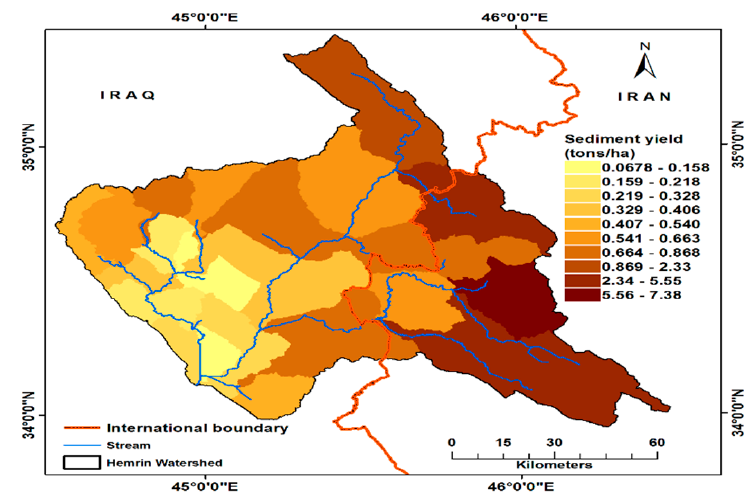
Figure 25. Result of senario-1 (M-1) of sediment mitigation.